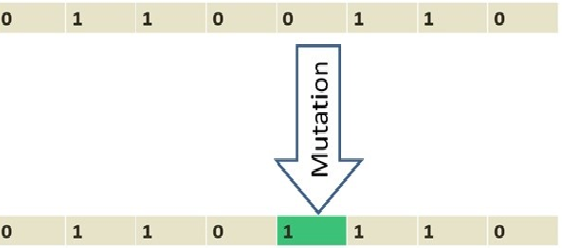
Figure A2. Mutation